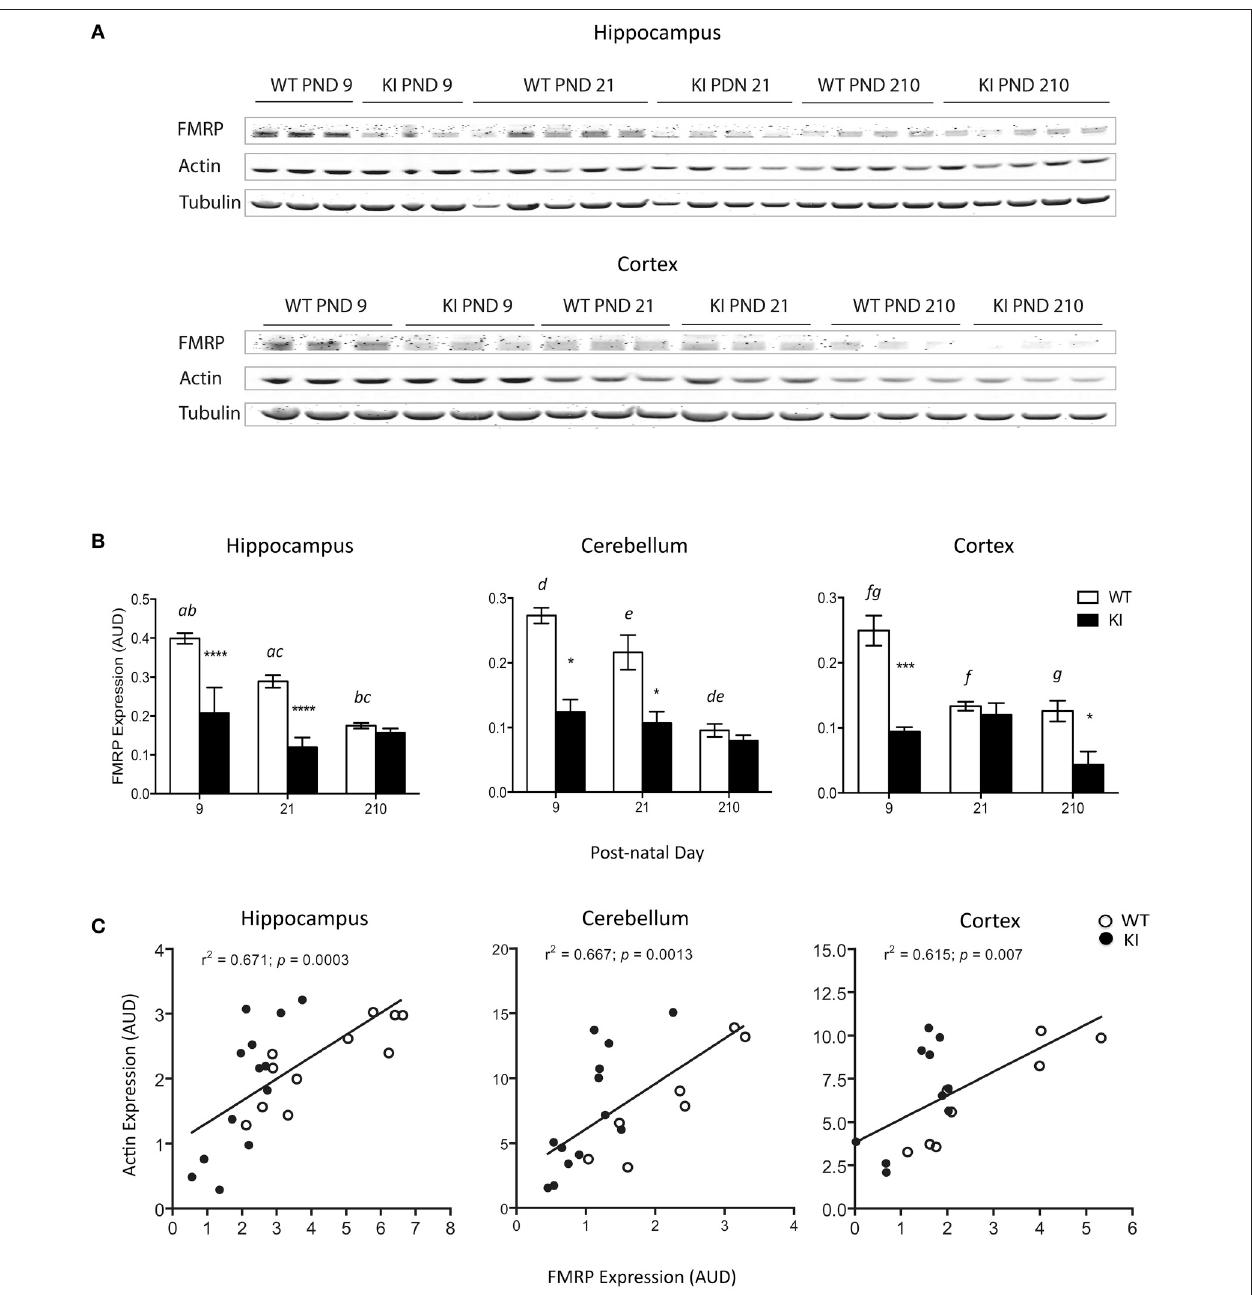
FIGURE 1 | Changes in FMRP protein expression in brain from WT and KI mice. (A) Representative Western blots of FMRP and actin protein expression levels in hippocampus and cortex of WT and KI mice. Tubulin was used as loading control. FMRP protein levels of KI mice hippocampus and cerebellum were 37 and 45% of WT at post-natal day (PND) 9, and 41 and 50% of WT at post-natal day 21. In cortex, FMRP protein levels in KI mice were 38% of WT at post-natal day 9. (B) Time-dependent changes in FMRP protein levels in hippocampus, cerebellum, and cortex respectively. Data are reported as mean ± SEM, n = 3–5 per genotype per time point. Statistical analysis was performed by Two-way ANOVA. Post-hoc analysis performed by Tukey’s HSD test revealed significant differences between WT and KI, indicated in the figure by asterisk as follows. Hippocampus: **** p < 0.0001; Cerebellum: * p = 0.0110; Cortex: ** p = 0.0003, * p = 0.0363, *** p = 0.0001. Statistically significant differences among time points are indicated by letters with the following p values. p = 0.0029 ( a ), p < 0.0001 ( b ), p = 0.0009 ( c ), p = 0.0260 ( d ), p = 0.0101 ( e ), p = 0.0033 ( f ), p = 0.0020 ( g ). For more statistical details on the genotype, age, and genotype × age effect see Table 3 . (C) Correlation between FMRP and actin in the same brain areas. AUD, Arbitrary Units of